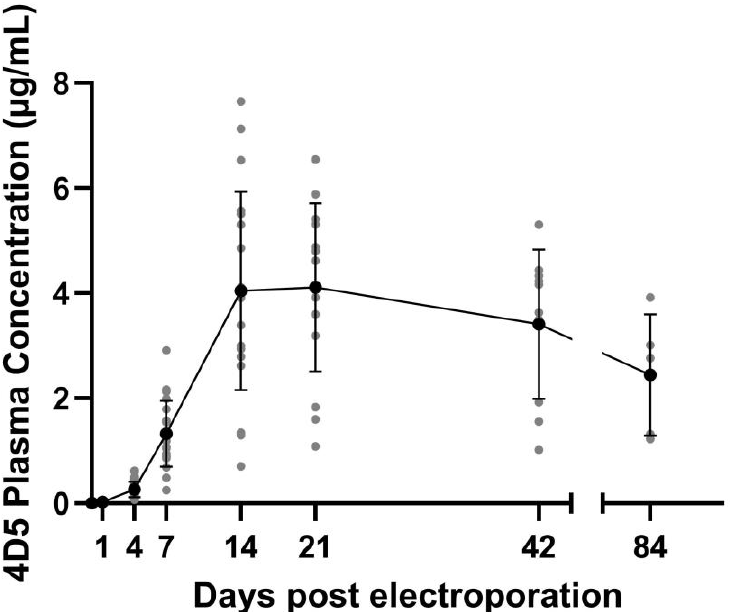
Figure 3. 4D5 antibody expression levels. Balb/c mice received intramuscular pDNA electrotransfer of 60 µg pDNA (equimolar mixture pCAG-4D5-HC and pCAG-4D5-LC) in both tibialis anterior muscles. 4D5 mAb plasma concentrations, dots indicate the individual expression levels per animal, the solid line indicates the average levels including standard deviation. Number of animals decreases at each subsequent time point due to the terminal procedure upon muscle isolation ( n = 35 (24 h, only 5 above LOQ); n = 30 (4 days); n = 25 (week 1); n = 20 (week 2); n = 15 (week 3); n = 10 (week 6); n = 5 (week 12)).